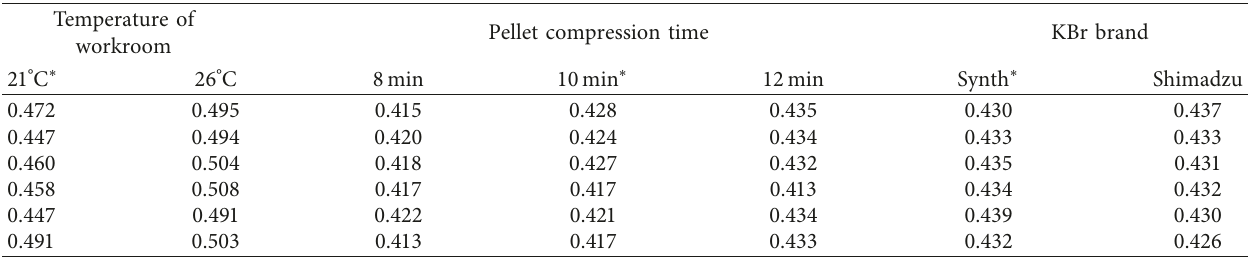
Table 4: Absorbances obtained during the robustness evaluation of the spectrophotometric method in the mid-infrared region for the analysis of amoxicillin capsules.